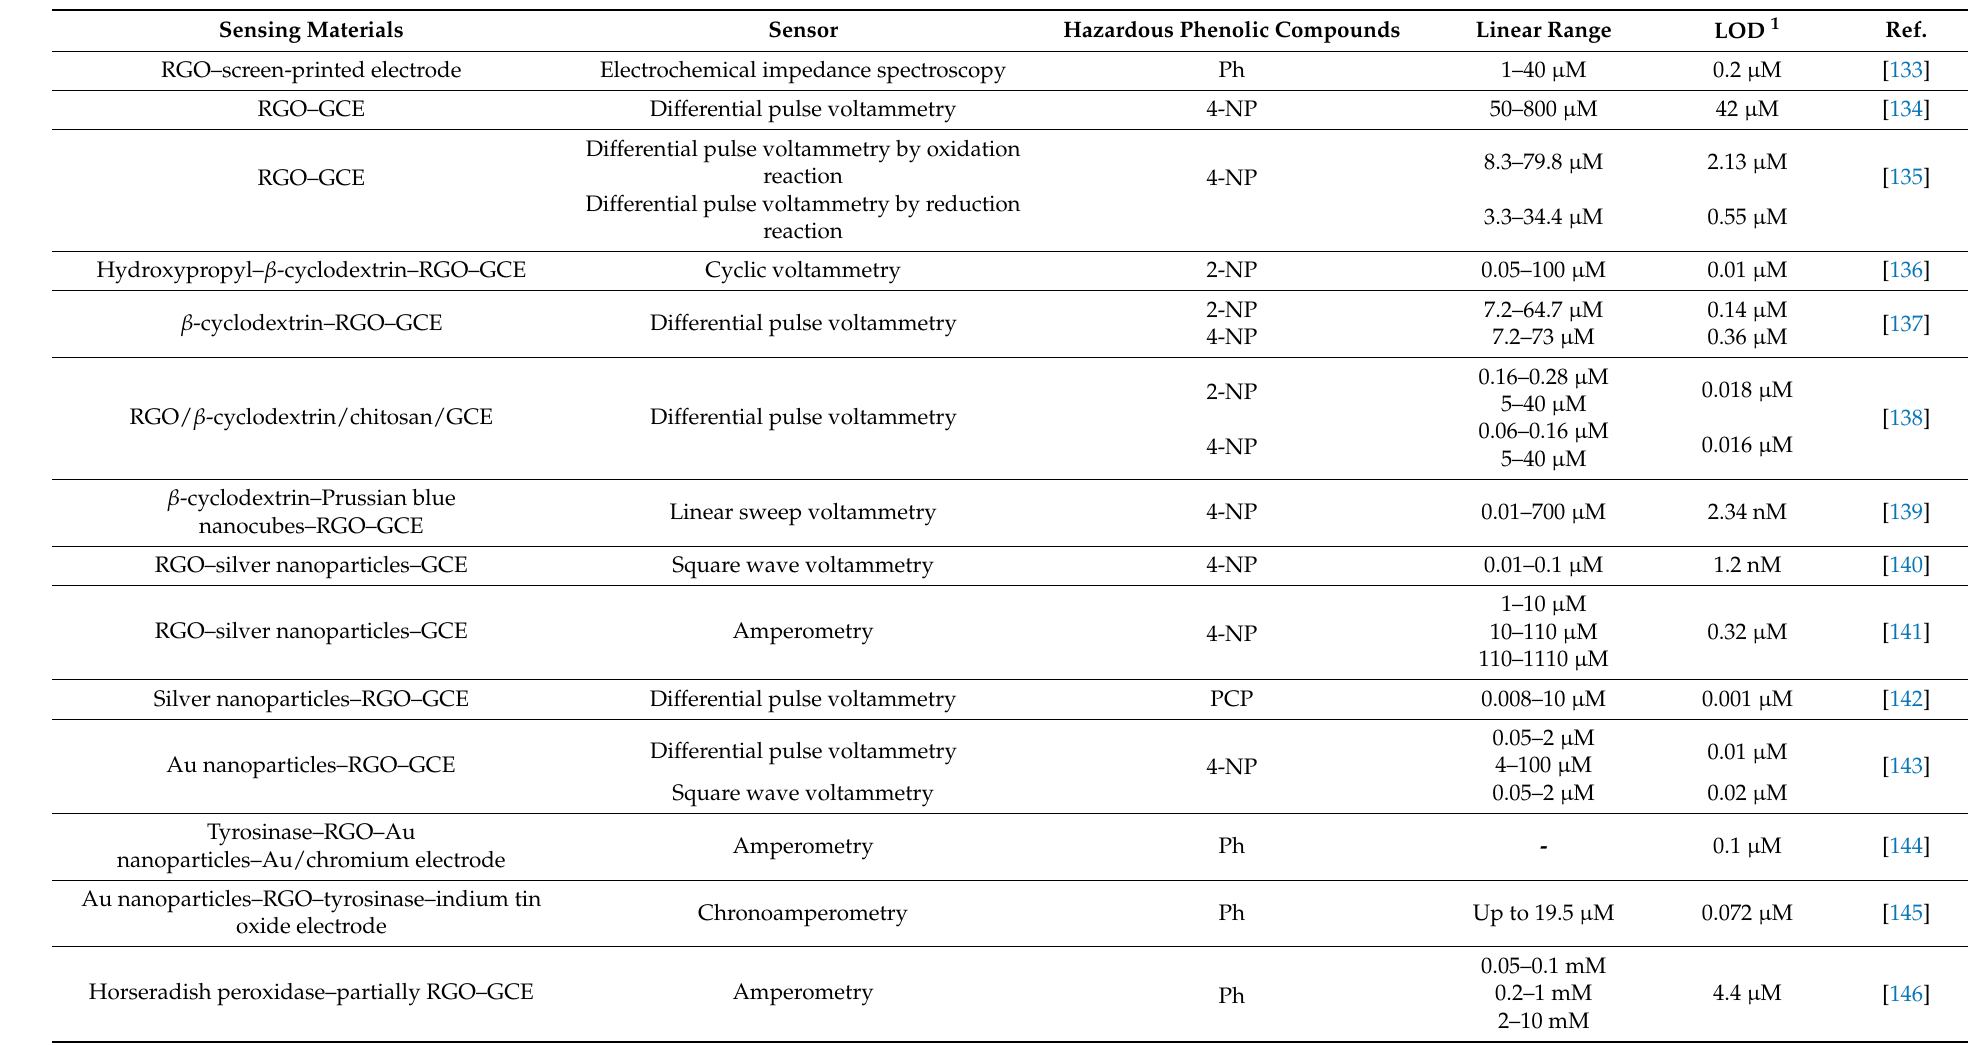
Table 4. RGO-based materials incorporated with electrochemical sensors for hazardous phenolic compounds